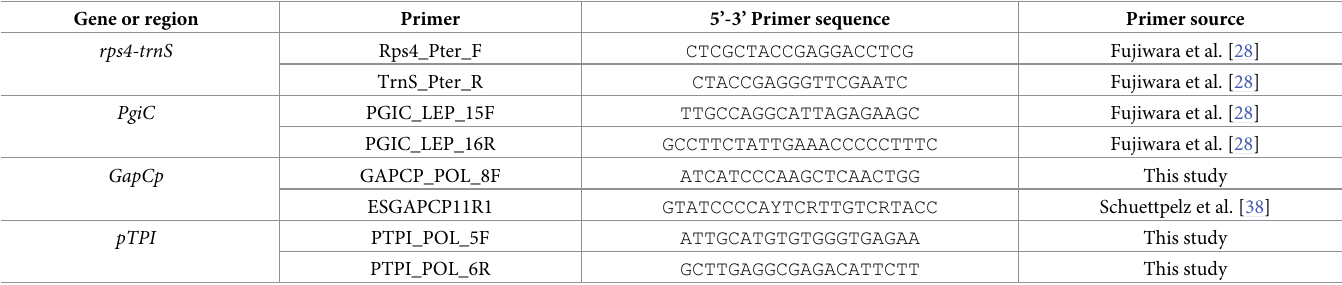
Lepisorus kuratae is an allotetraploid of hybrid origin between L . thunbergianus and an unknown diploid race of L . tosaensis and was described as a new species jointly with L . nigripes [28]. DNA extraction, PCR amplification and nucleotide sequencing Total genomic DNA was extracted from a silica gel-dried sample using the CTAB method [36]. A chloroplast DNA region, an intergenic spacer between rps4 and trnS (hereafter r ps4-trnS ), was amplified using the primers rps4_PTER_F and trnS_PTER_R1 [28]. For sin- gle-copy nuclear genes, we selected three genes, PgiC (cytosolic phosphoglucose isomerase), GapCp (NAD-dependent glyceraldehyde-3-phosphate dehydrogenase) and pTPI (plastidic tri- ose phosphate isomerase). Intron 15 of PgiC was amplified using the primers reported by Table 2. Primers used for PCR amplification and sequencing of the chloroplast DNA and nuclear genes. Gene or